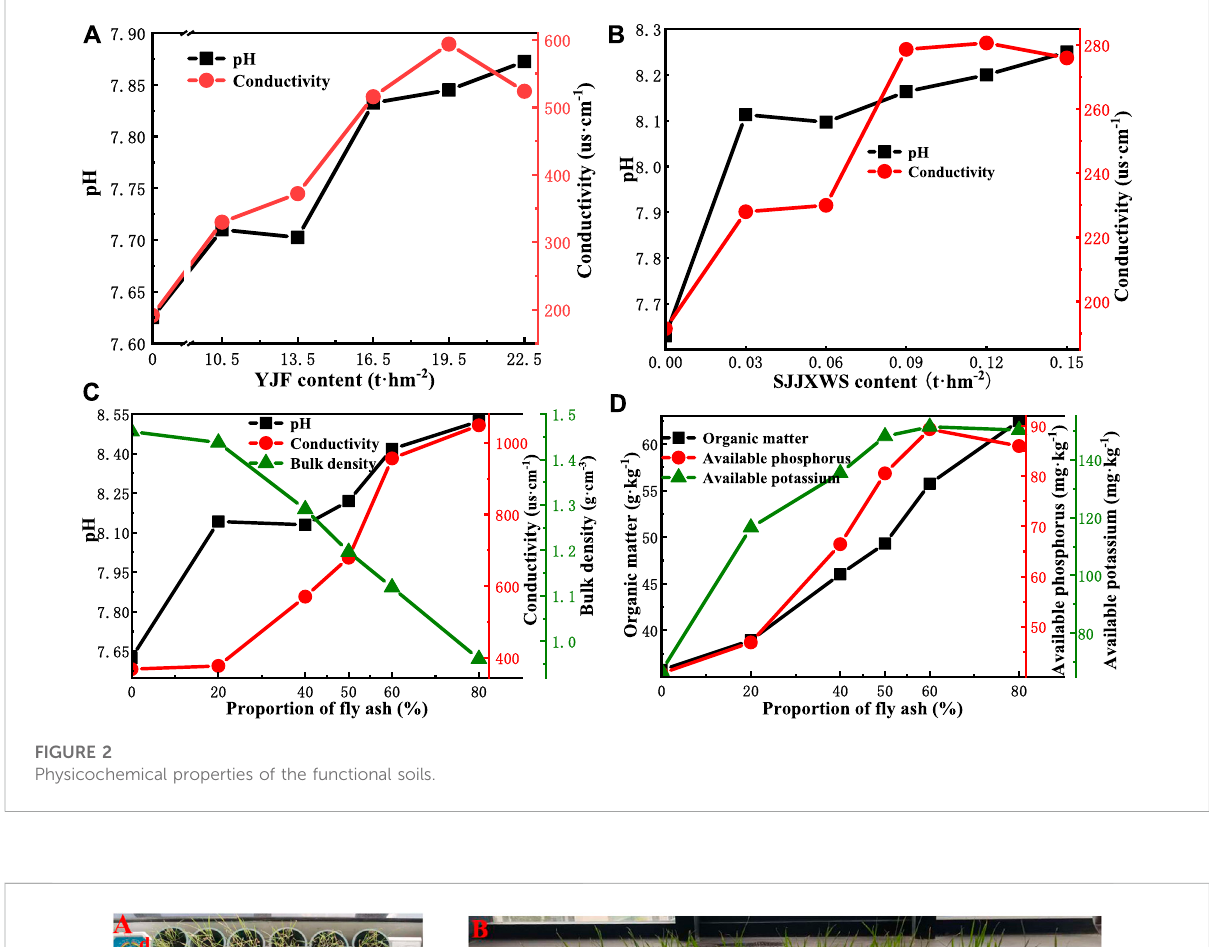
FIGURE 2 Physicochemical properties of the functional soils.